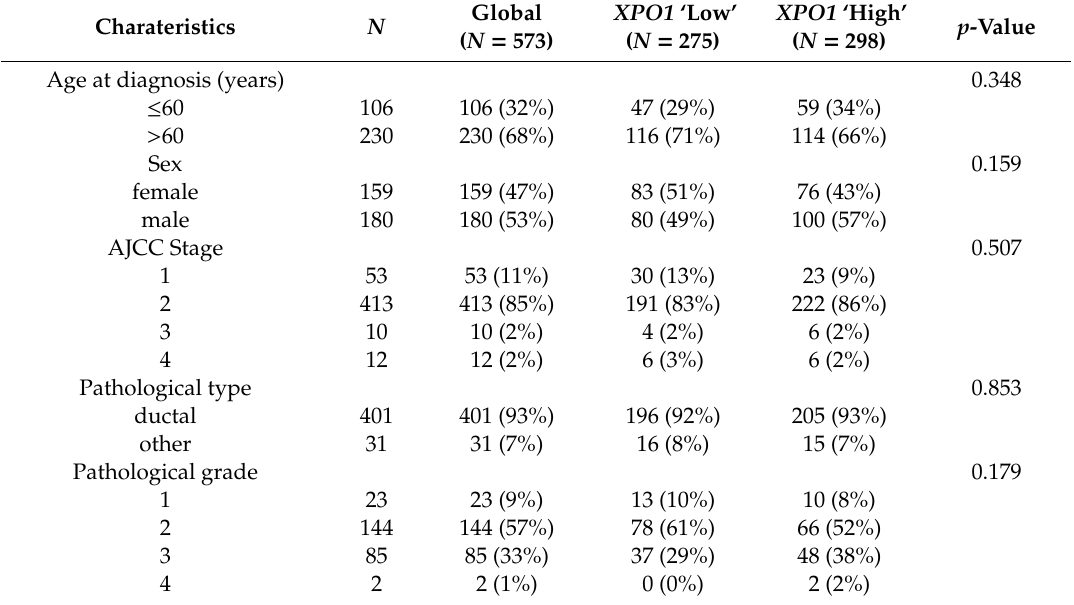
Table 1. Clinico-pathological and molecular characteristics of 573 primary pancreatic adenocarcinoma (PAC) samples in the whole population and in each exportin-1 (XPO1)-based group. Charateristics N